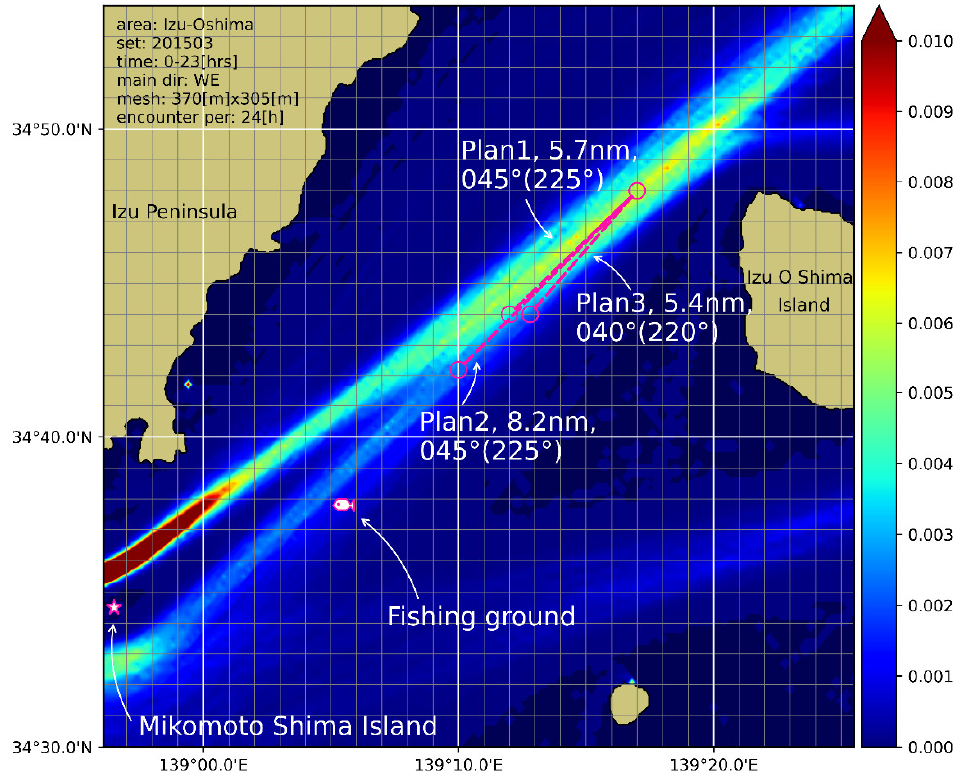
Figure 10. The RR candidates. (Source: AIS data from March 1 to March 31, 2015, provided by TST [32]).